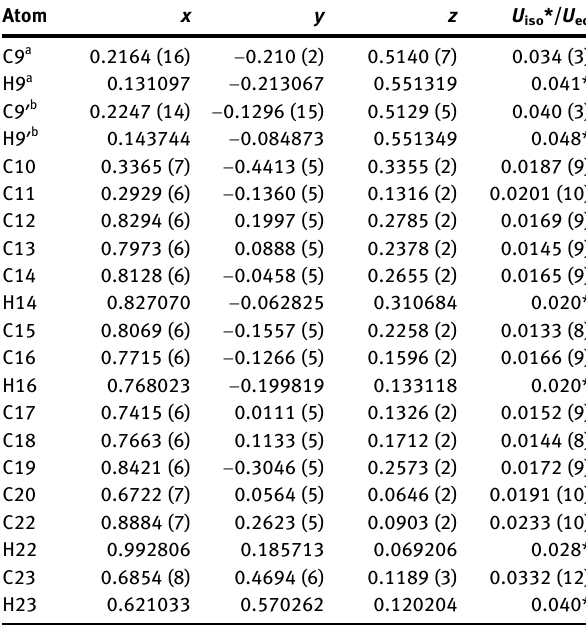
Table  : Fractional atomic coordinates and isotropic or equivalent isotropic displacement parameters (Å 